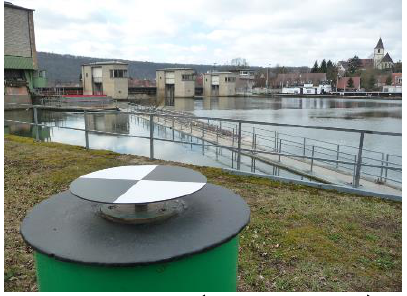
Figure 1. The ship lock (monitoring object) and a photogrammetric control point marked with a forced- centering checkerboard target on a pillar in the foreground. PhaseOne iXU-RS 1000 nadir images have been captured using the CopterSystems CS-SQ8 copter that is optimized for PhaseOne camera payloads. 18 consecutive flight missions were necessary to fully cover the area of interest. 3775 images with 80/60 overlap are arranged in 146 mostly north-south oriented flight lines, as the Neckar River’s cardinal orientation is almost north-south for this test area (cf. Figure